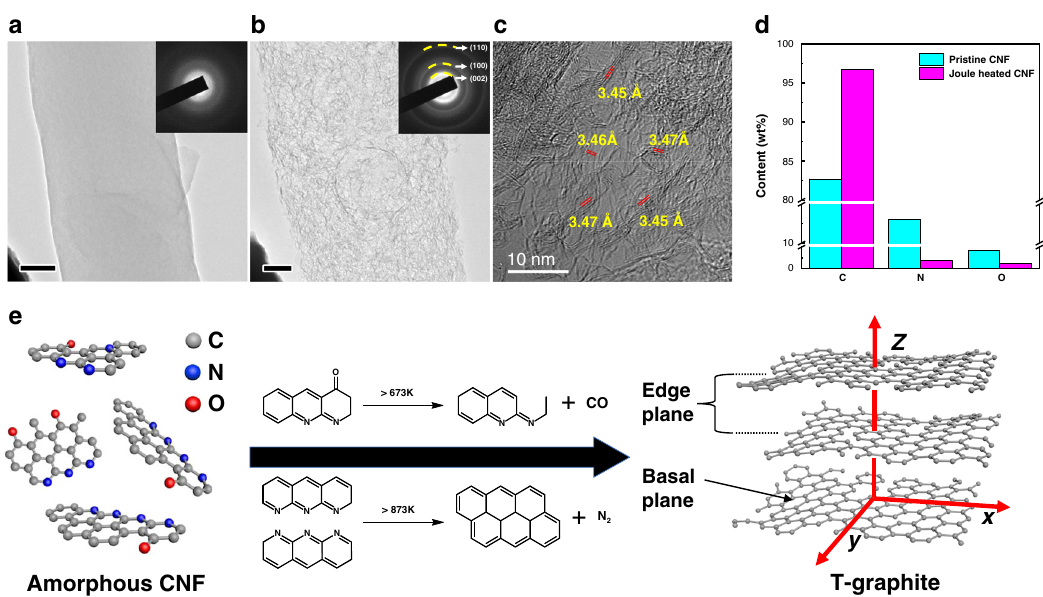
Fig. 3 TEM and EDS analyses of pristine amorphous CNF evolution during Joule heating. a TEM image of original CNF without salt loading is shown. The corresponding SAED pattern displays diffusive rings, which is a characteristic of an amorphous structure. Scale bar is 50 nm. b TEM image of wrinkled CNF achieved after Joule heating, where the SAED pattern shows sharp rings, corresponding to T-graphite. Scale bar is 50 nm. c HRTEM image of the wrinkled structure and d quantitative EDS analysis of carbon, nitrogen and oxygen content in a CNF before and after Joule heating. e Amorphous CNF evolution during Joule heating and typical routes of N and O removal at high